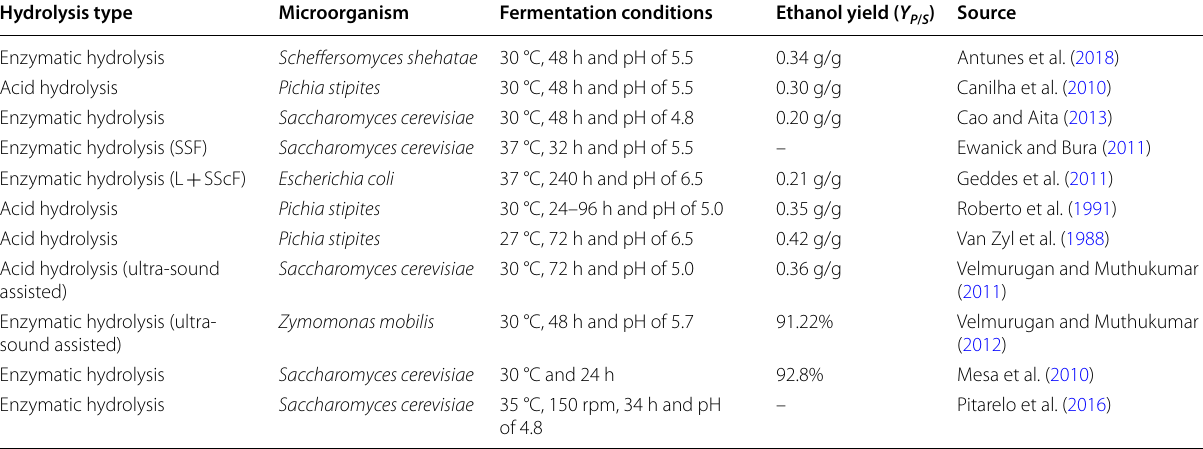
Table 4 Summary of bio-ethanol production from SCB Hydrolysis